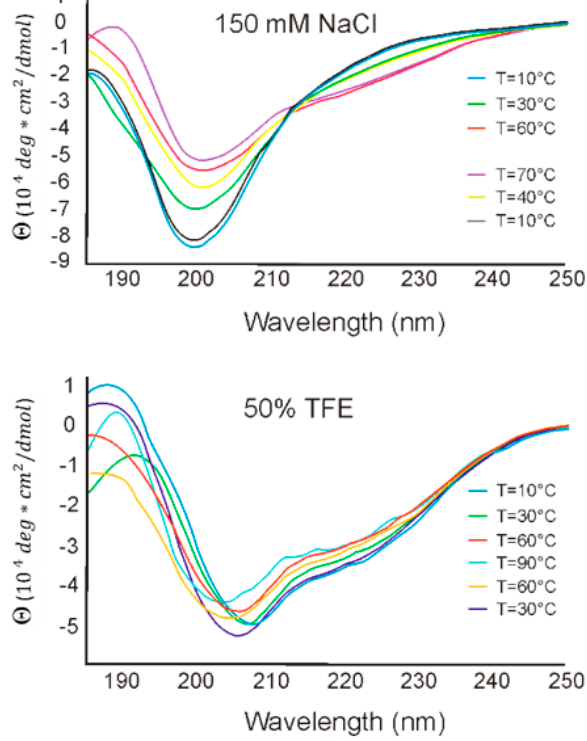
Figure 5. CD spectra of RL2 in aqueous and hydrophobic (trifluoroethanol; TFE) solutions.